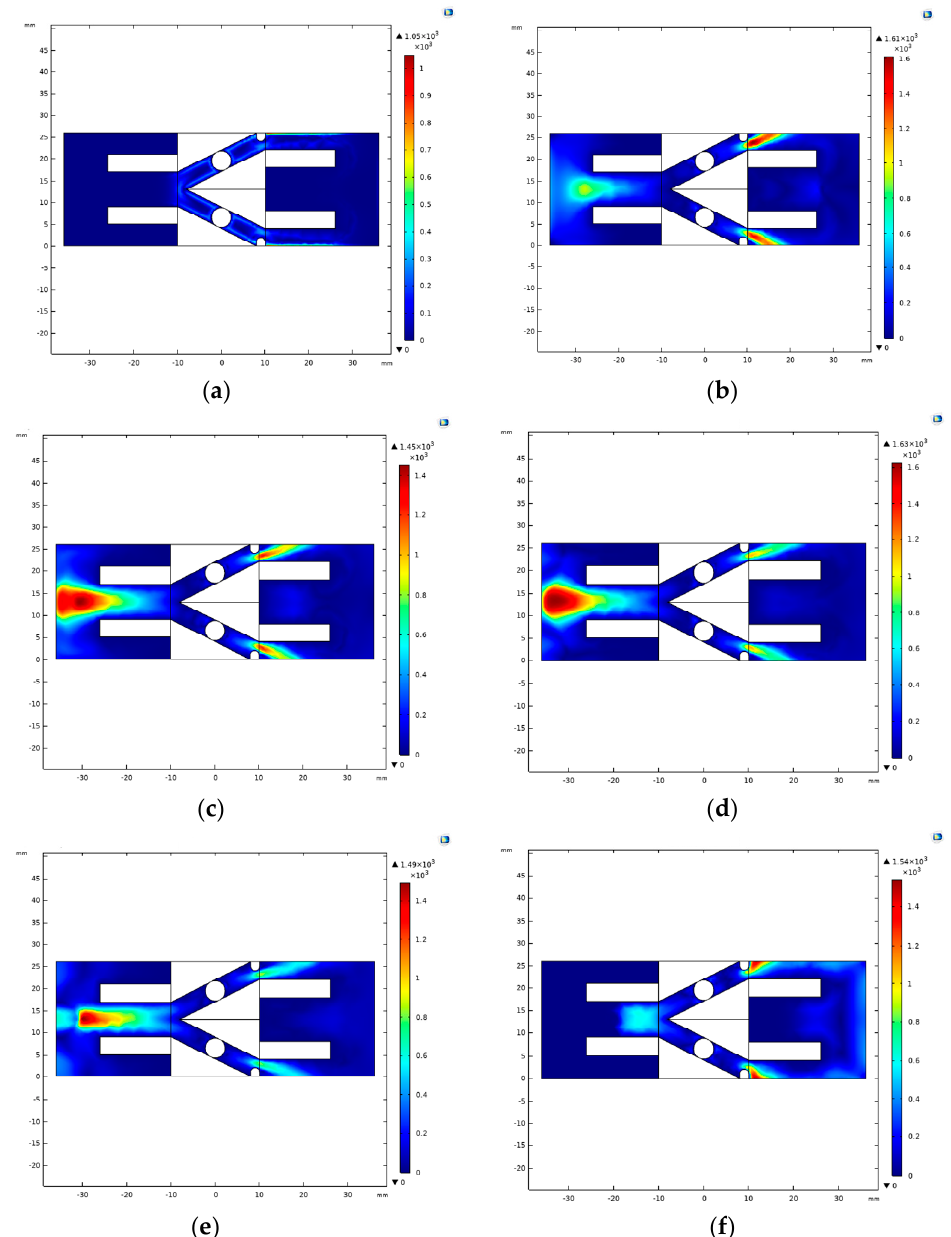
Figure 5. Map of the airflow velocity distribution. ( a ) 0.02 ms, ( b ) 0.78 ms, ( c ) 1.35 ms, ( d ) 1.82 ms, ( e ) 2.15 ms, ( f ) 2.32 ms. ( e ) 2.15 ms, ( f ) 2.32